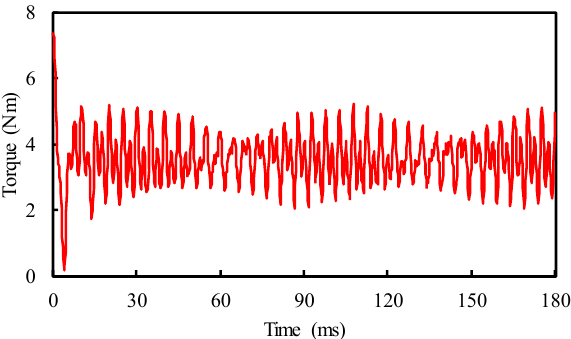
Figure 13. FFT of the currents.